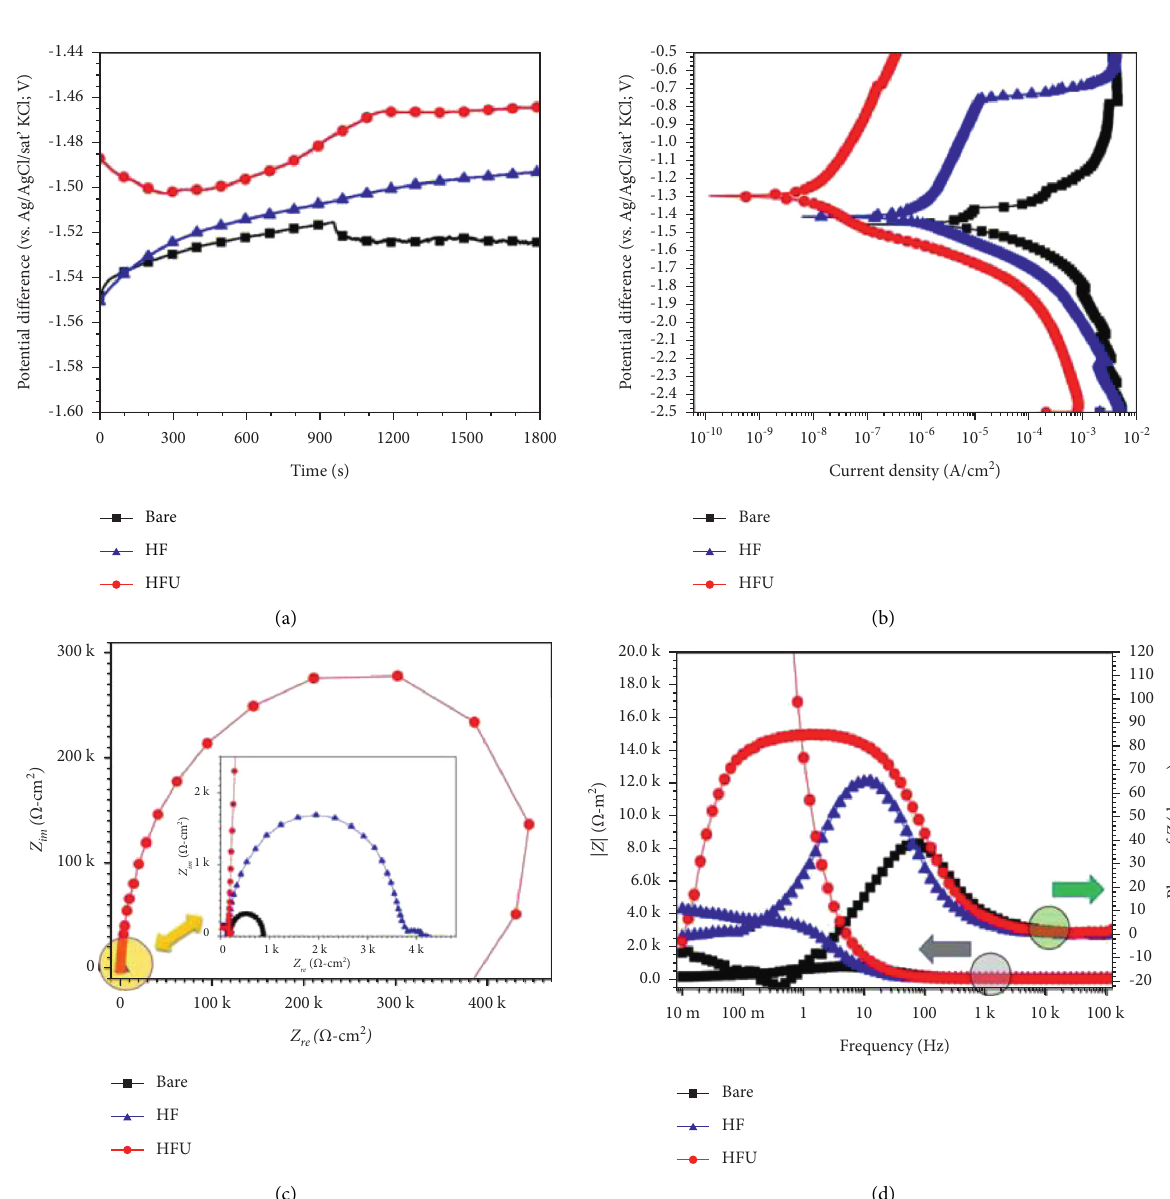
Figure 6: Electrochemical corrosion results. OCP (a), PDP (b), Nyquist (c), and bode (d) curves of the bare and HF- and HFU-coated AZ31 alloys